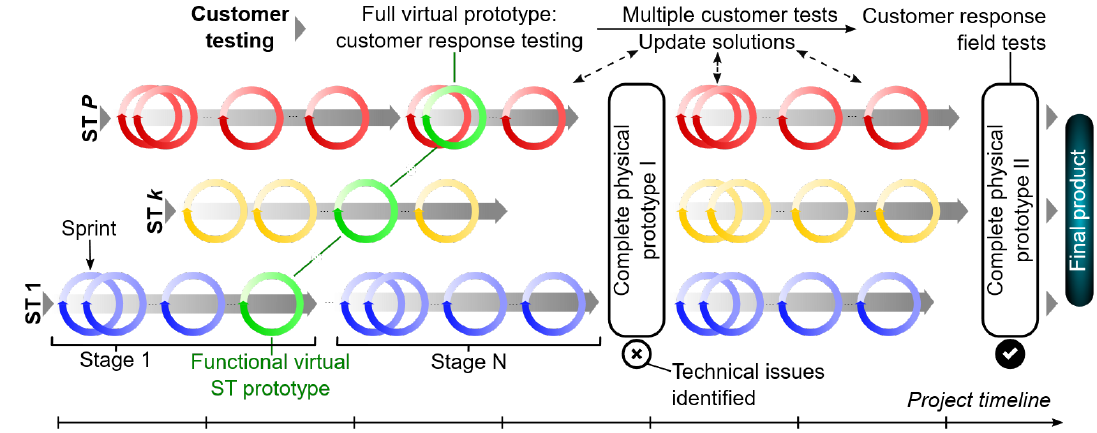
Figure 12. Exemplary project timeline, based on the Agile product development process.